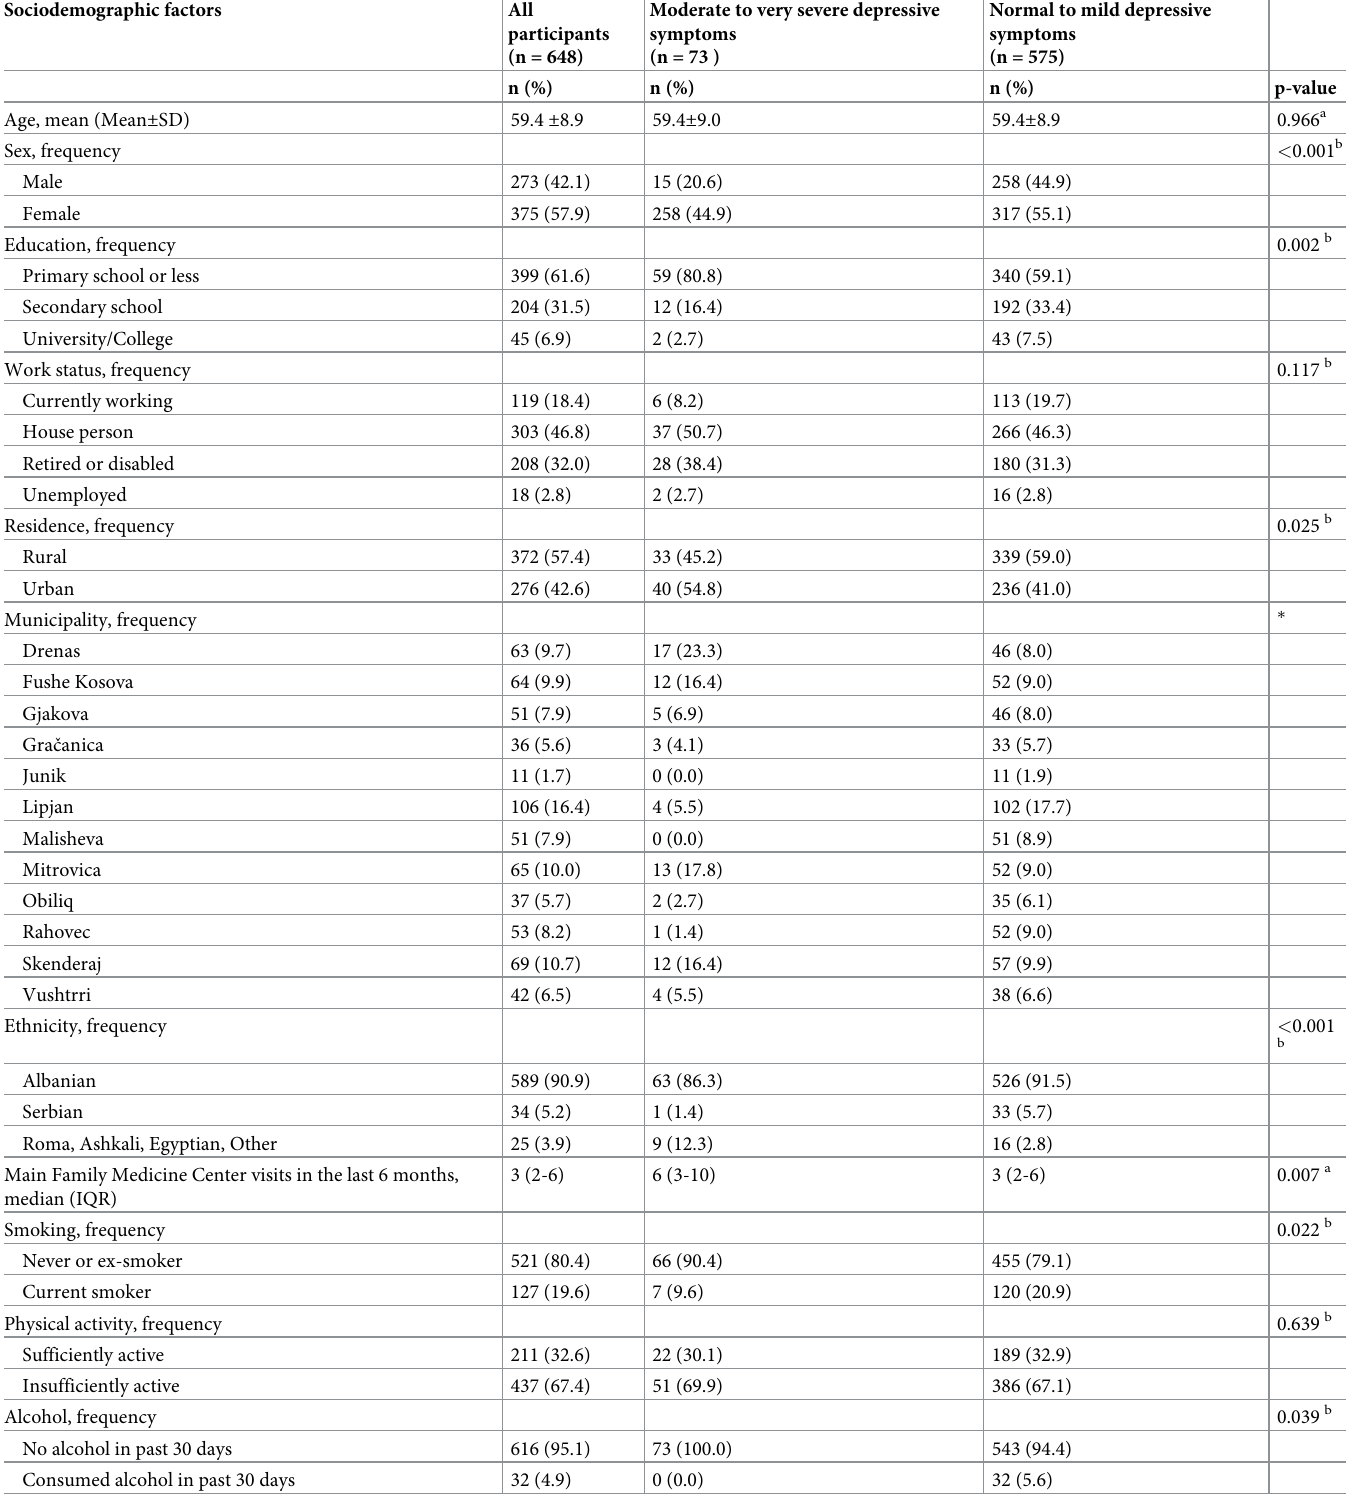
Table 2. Baseline participant characteristics also disaggregated by depressive symptoms